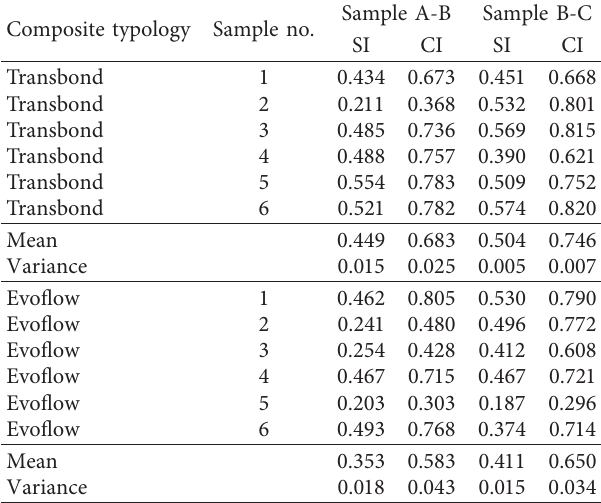
Table 2: Estimate of the similarity and correlation indicators between the samples A-B and B-C in the case of two composite materials, labelled transbond and evoflow, respectively. Composite typology Sample